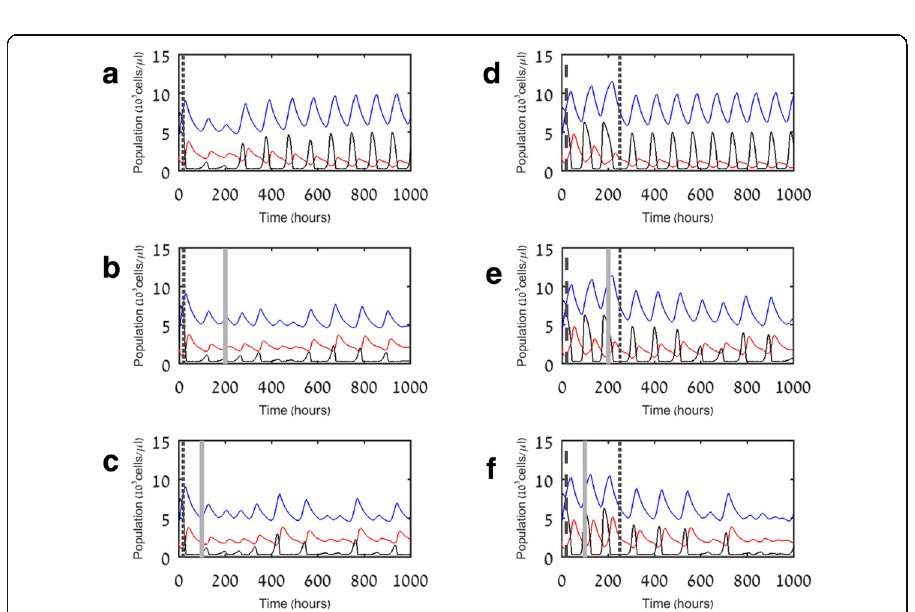
Fig. 6 Simulation results for treatment with different protocols of antibiotics and their combination with immunotherapy. a Targeted antibiotics alone. b Targeted antibiotics followed by immunotherapy after 200 h. c Targeted antibiotics followed by immunotherapy after 100 h. d Targeted antibiotics followed by targeted antibiotics after 250 h. e Targeted antibiotics followed by immunotherapy after 200 h and targeted antibiotics after 250 h. f Targeted antibiotics followed by immunotherapy after 100 h and targeted antibiotics after 250 h. Blue, red, and black lines indicate myeloid cells (M), lymphocytes (L), and pathogen (P), respectively. Dotted vertical lines indicate time of administration of strong targeted antibiotics (reduction of 40% in pathogen growth rate, p P, to 1.2); straight vertical gray lines indicate time of administration of immunotherapy; dashed vertical lines indicate time of administration of weak broad spectrum antibiotics (reduction of 20% in pathogen growth rate, p P , to